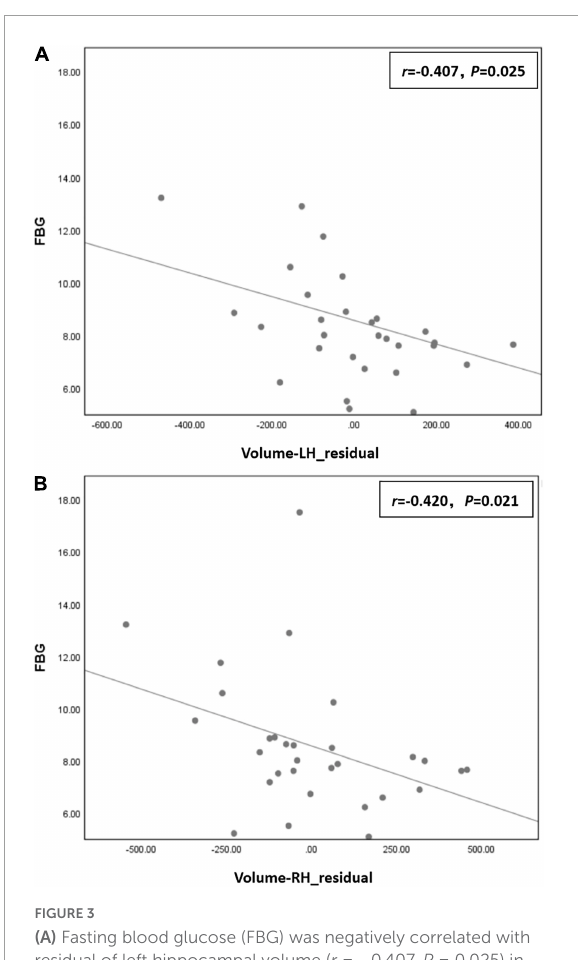
FIGURE3 (A) Fasting blood glucose (FBG) was negatively correlated with residual of left hippocampal volume ( r = –0.407, P = 0.025) in the type 2 diabetes mellitus (T2DM) group. (B) FBG was negatively correlated with residual of right hippocampal volume ( r = –0.420, P = 0.021) in the T2DM